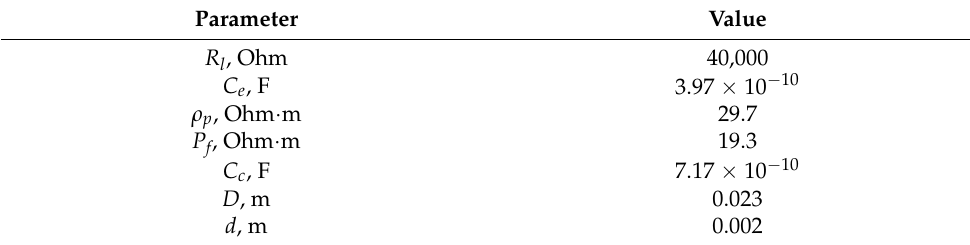
Figure 14. Electrical model of a section of a tree branch connected to an impedance meter. R l is the leakage resistor forming leakage current along the surface of the bark, R p is the phloem resistance, R x is the xylem resistance, C e represents the capacitors formed by electrode connection points and non-conductive layers of the sclerenchyma, periderm, and epidermis, C c is a capacitor formed by a non-conductive layer of cambium, and arrows are the points of attachment to the measuring equipment. Table 3. Model